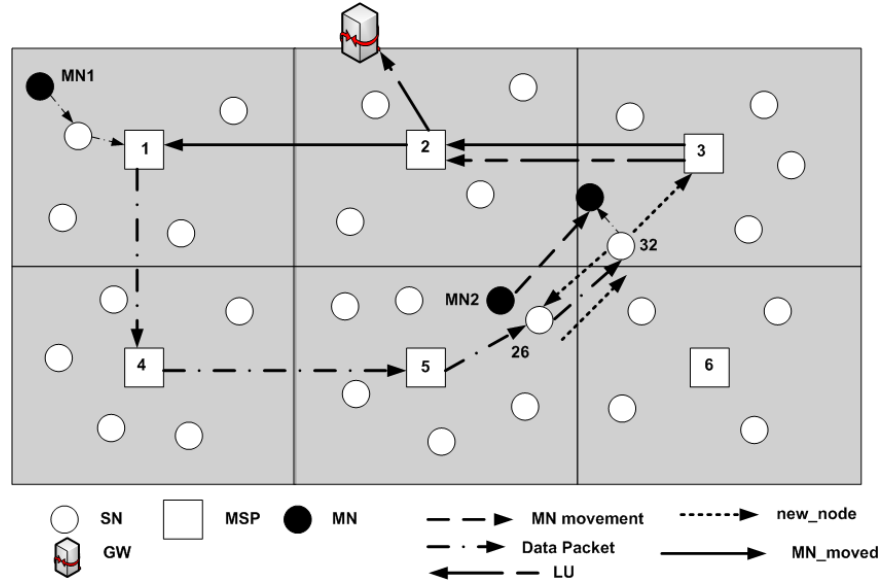
Figure 13. Handoff process in DLoWMob with Route Optimization